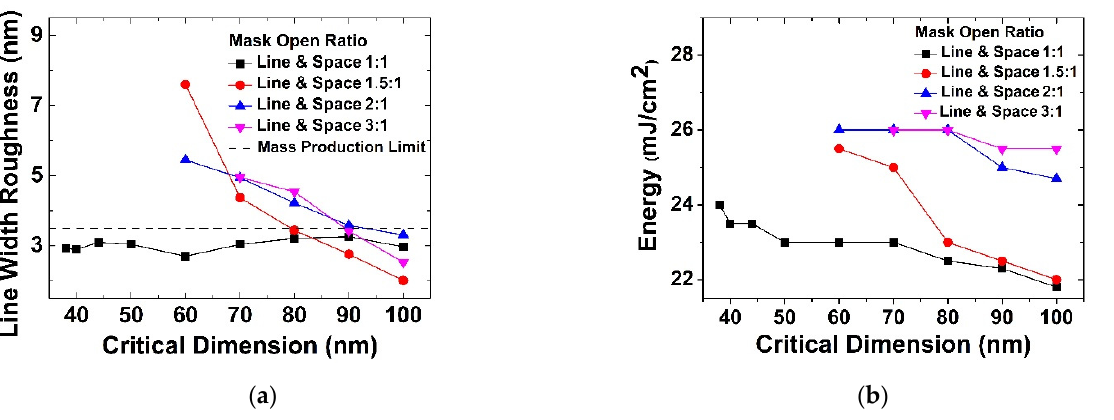
Figure 4. Experimental results on ( a ) LWR, and ( b ) expose energy according to mask open area ratio with fixed NA of 1.35.